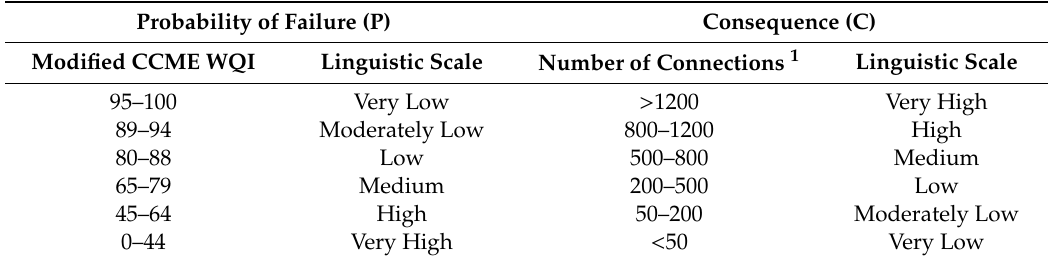
Table 3. Linguistic scales defined for risk